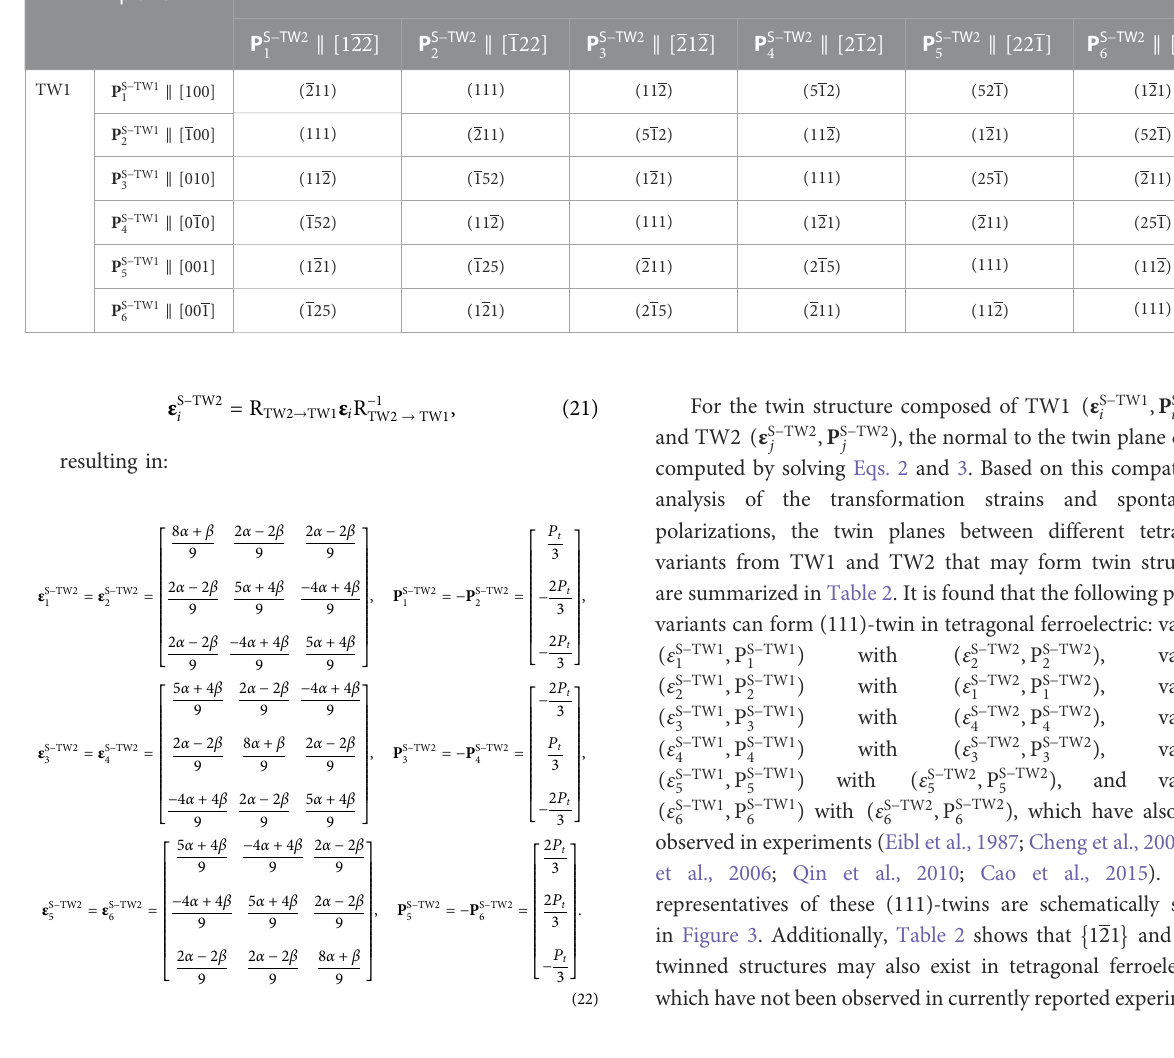
TABLE 2 The possible twin planes formed between various tetragonal variants identi fi ed by compatibility analysis. Note that all the polarization directions and twin plane normal are indicated in the local coordinate system x TW 1 1 x TW 1 2 x TW 1 3 . TW